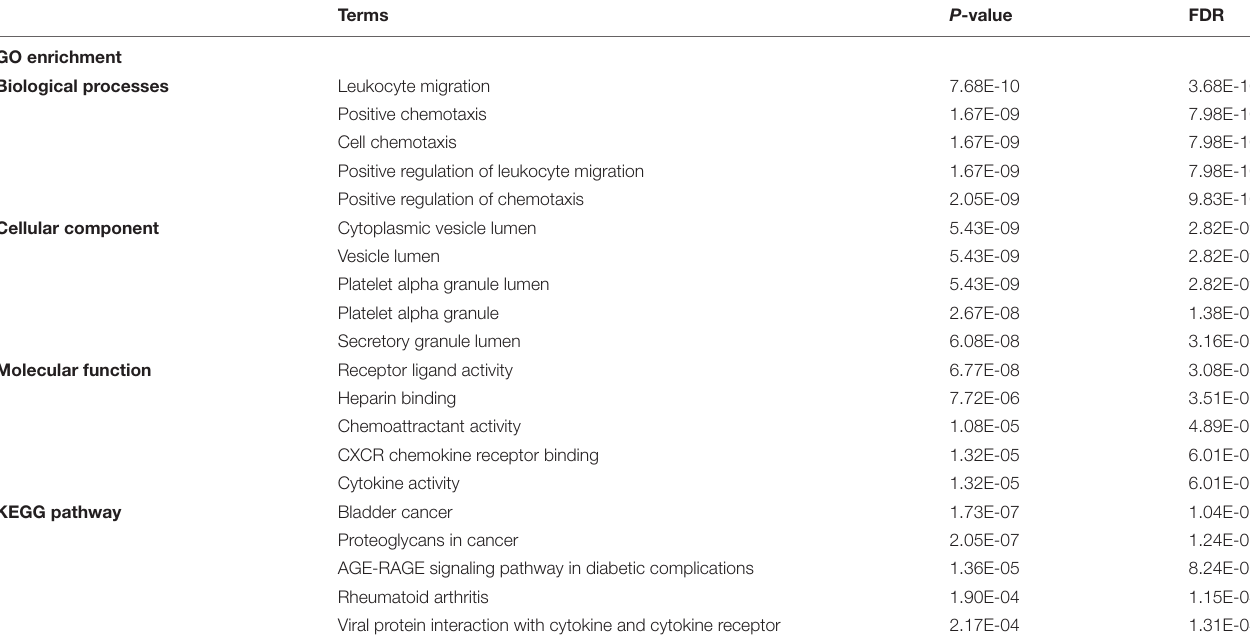
FIGURE 5 | Protein–protein interaction network and modules screening. (A) PPI network of DEOGs. (B) Critical module from PPI network. Green circles represent down-regulated genes, and red circles represent up-regulated genes. TABLE 1 | Kyoto encyclopedia of genes and genomes pathway and GO enrichment analysis of OS genes in key